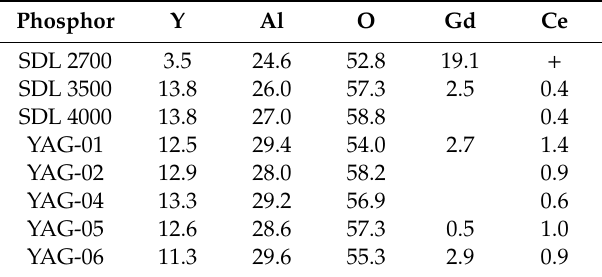
Table 1. Elemental composition of the SDL and C-YAG phosphors synthesized in 2016 (at.%). Phosphor Y Al O